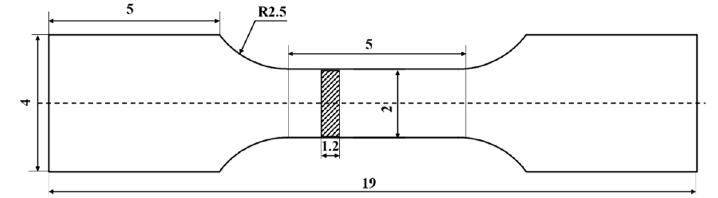
Figure 2. Structure diagram of tensile samples.